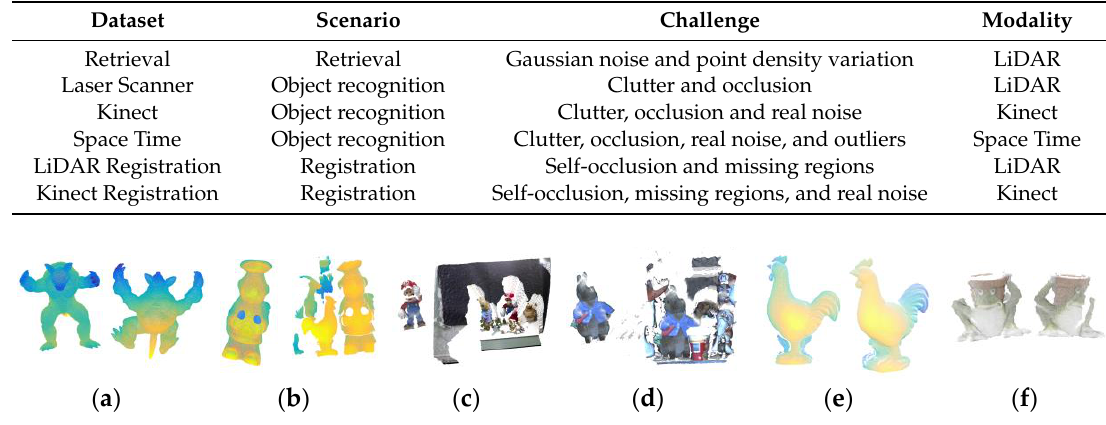
Figure 2. Experimental datasets. ( a ) Retrieval, ( b ) Laser Scanner, ( c ) Kinect, ( d ) Space Time, ( e ) LiDAR Registration, and ( f ) Kinect Registration. A model and a scene (from left to right) are presented as examples for each dataset.